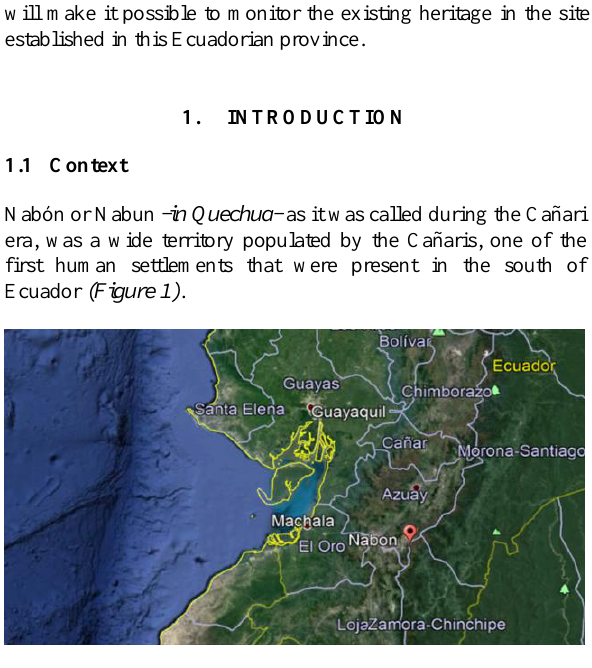
Figure 1 . Location of Nabón in Azuay’s Province and Ecuador (Source: Google Maps).